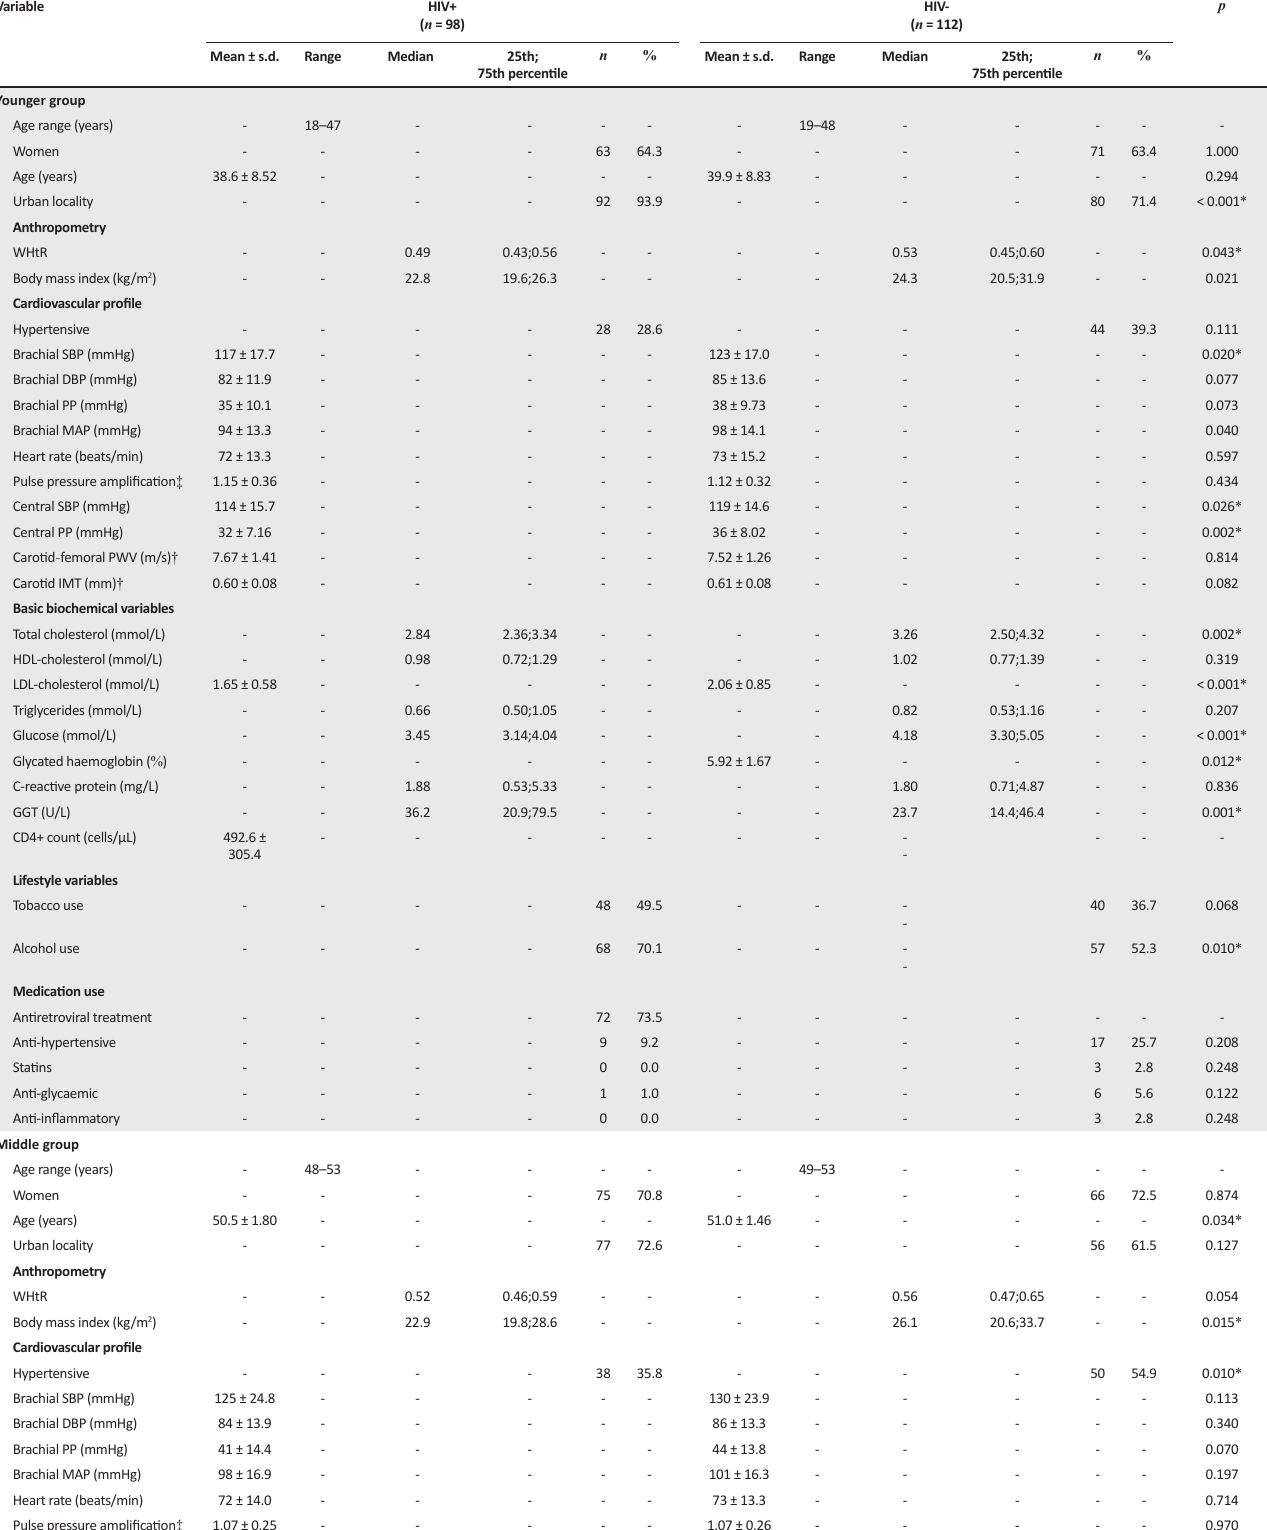
TABLE 1-A1 continues on the next page